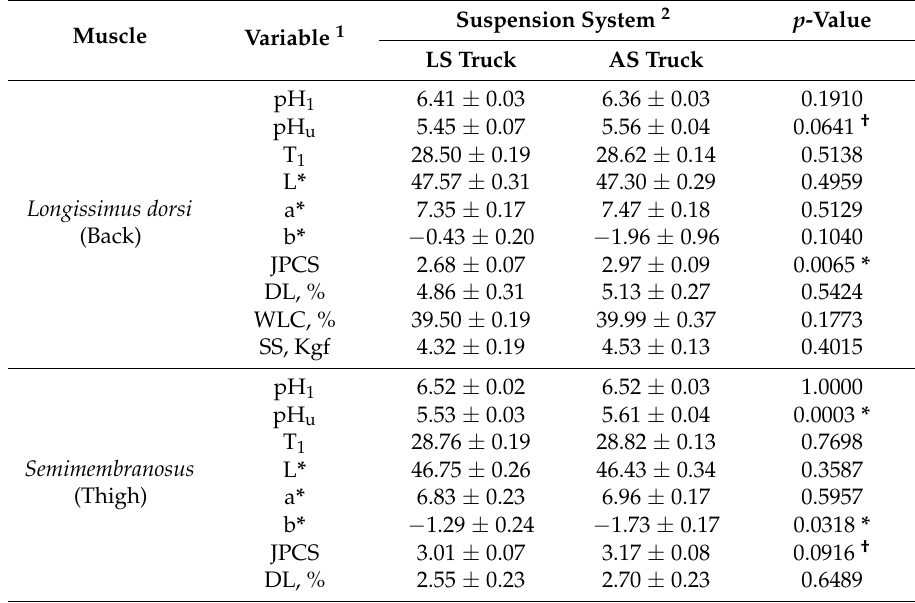
Table 6. Values (mean ± SE) of pork quality parameters of pigs transported by trucks with different suspension